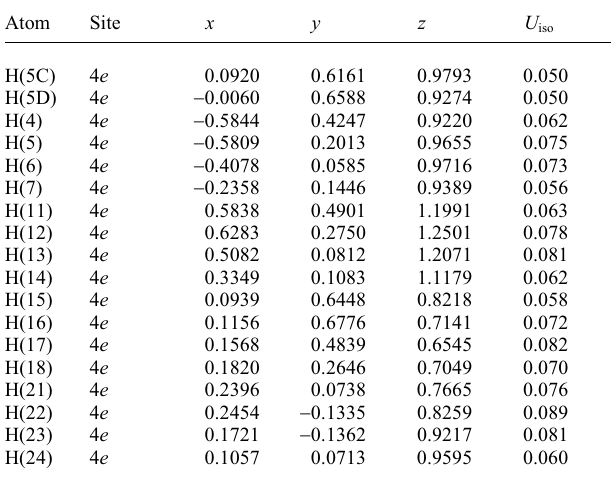
Table 2. Atomic coordinates and displacement parameters (in Å 2 )